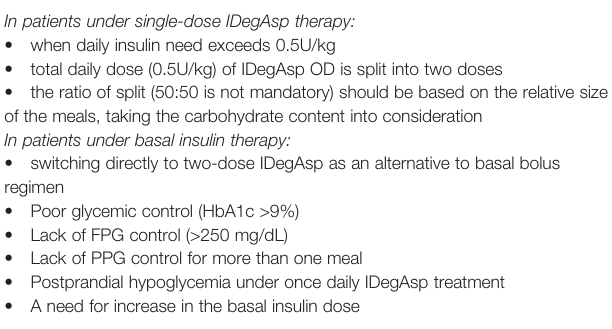
TABLE 4 | Expert Panel Recommendation 4: Twice daily IDegAsp